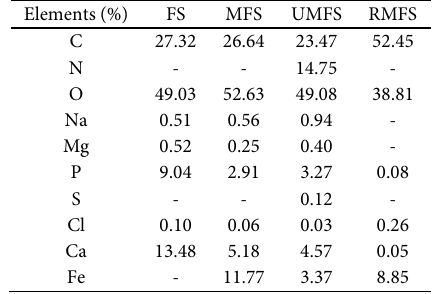
Table 1. Chemical composition based on the atomic percent obtained by EDX analysis